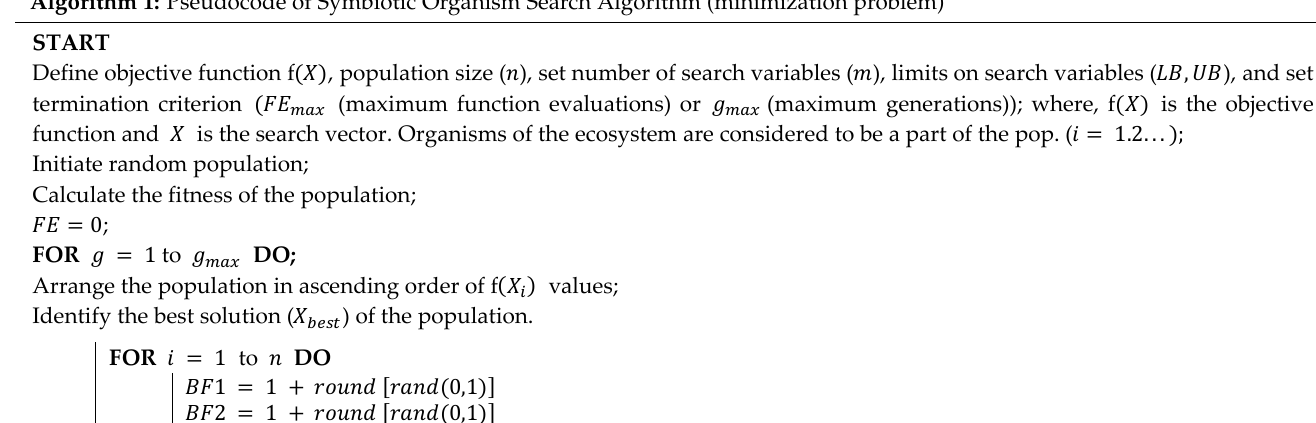
Algorithm 1: Pseudocode of Symbiotic Organism Search Algorithm (minimization problem)